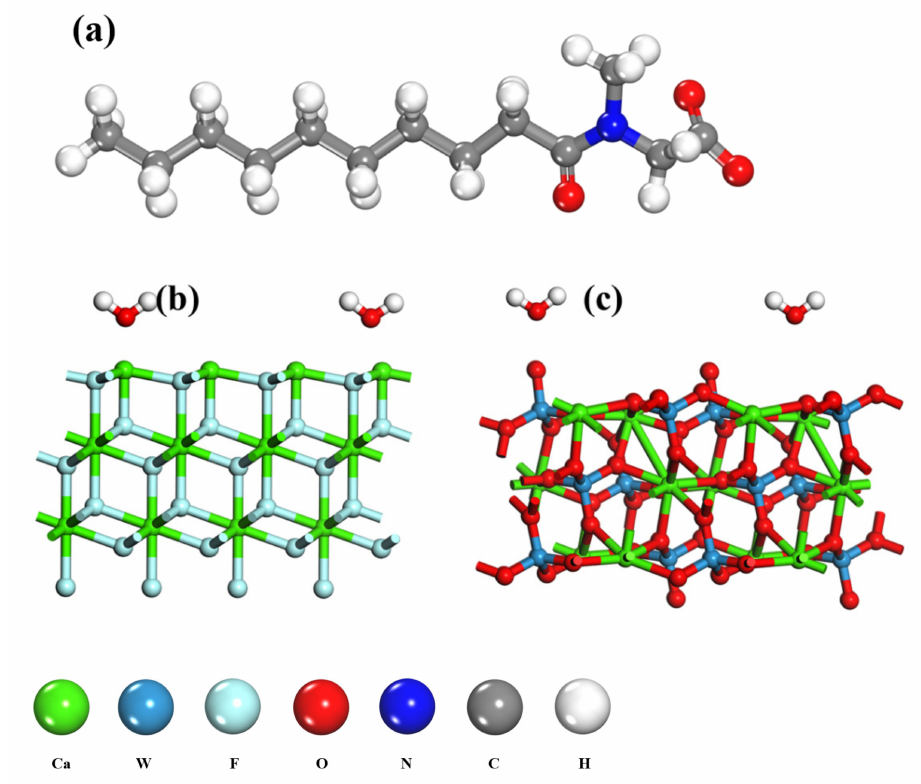
Figure 1. ( a ) Optimized geometry of SDAA anion slab model; ( b ) optimized geometry of fluorite slab model; and ( c ) optimized geometry of scheelite slab